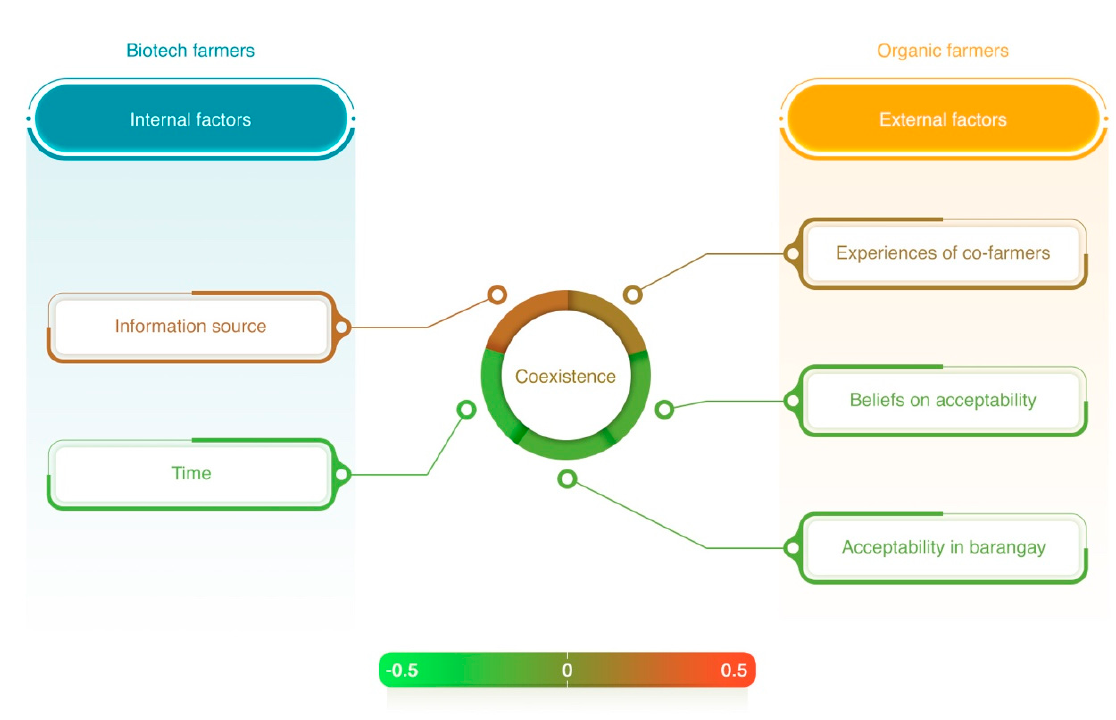
Figure 4. Heat diagram of internal and external factors affecting the coexistence perspective of biotech and organic farmers, guided by the CDM and the S–O–R Model.